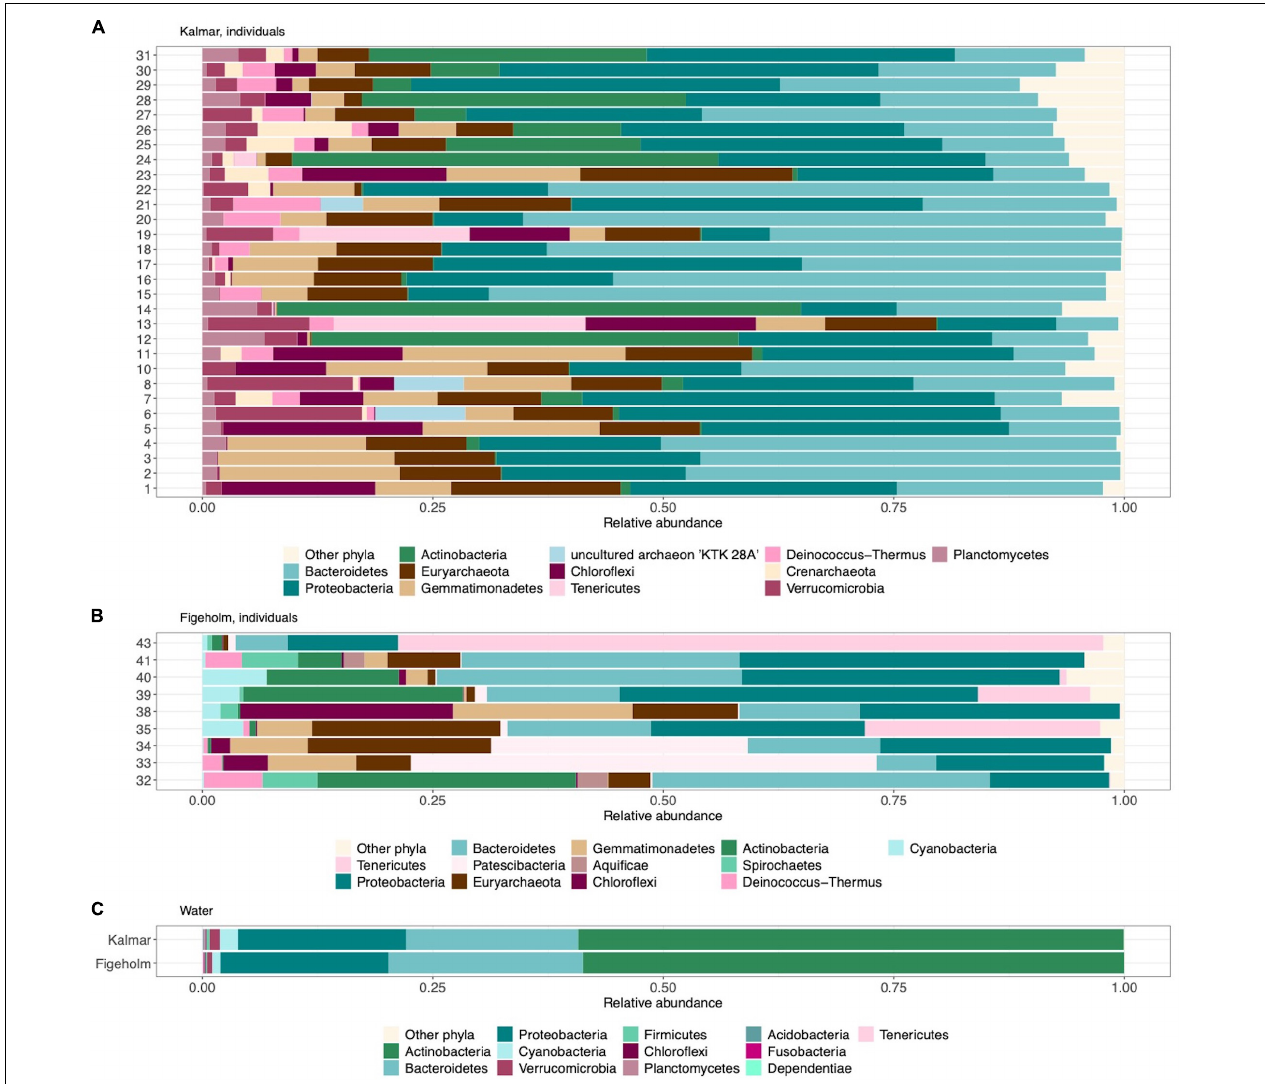
FIGURE 5 | Comparison of phylum-level composition in fish skin microbiome and bacterioplankton communities, ordered by increasing relative abundance from left to right. The 12 most abundant phyla based on relative abundance among fish skin microbiome samples within (A) population Kalmar ( n = 30 individuals), and (B) population Figeholm ( n = 9 individuals), respectively. Each number on the y-axis denotes an individual fish represented by either 2 or 4 samples. (C) Displays taxonomic comparison of bacterioplankton communities in the water samples from Kalmar ( n = 3) and Figeholm ( n = 1 ) and represent the 12 most abundant phyla among all water